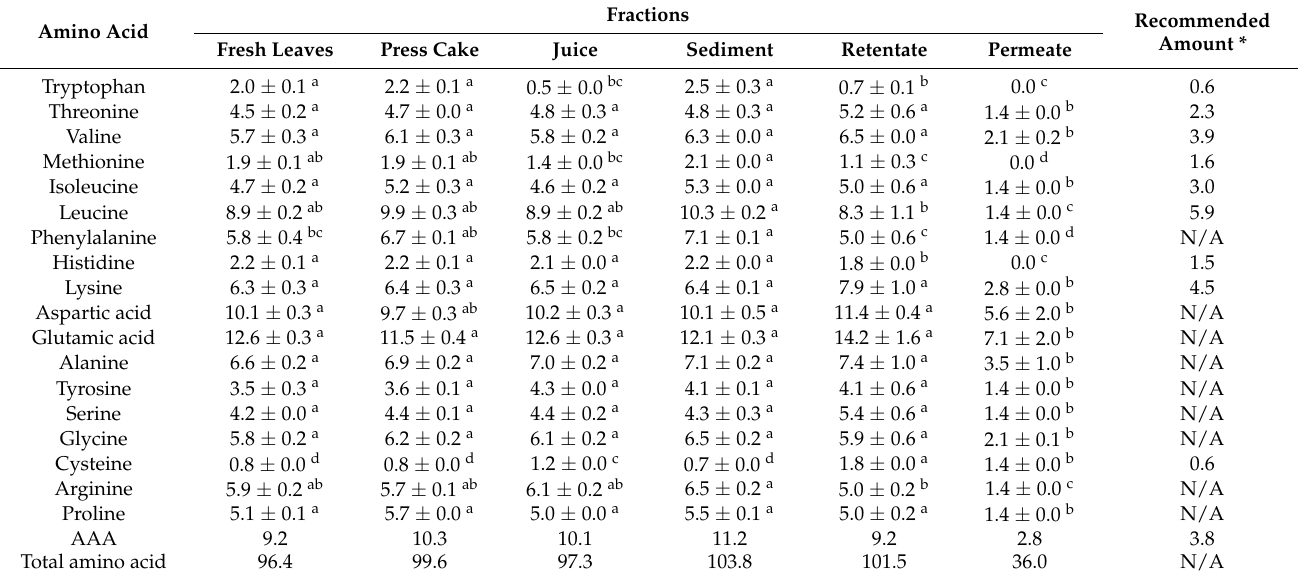
Table 1. Amino acid profile of leaf fractions after mechanical pressing and ultrafiltration (UF).